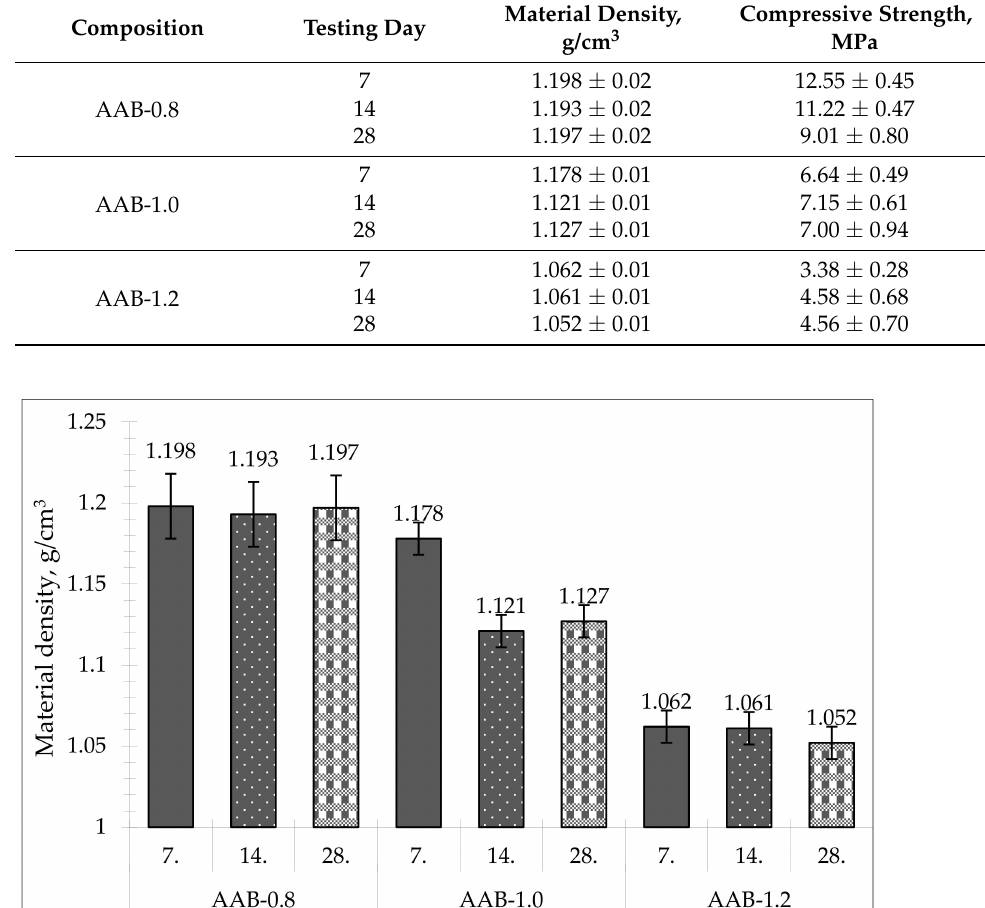
Table 4. Density and compressive strength of the produced AABs.